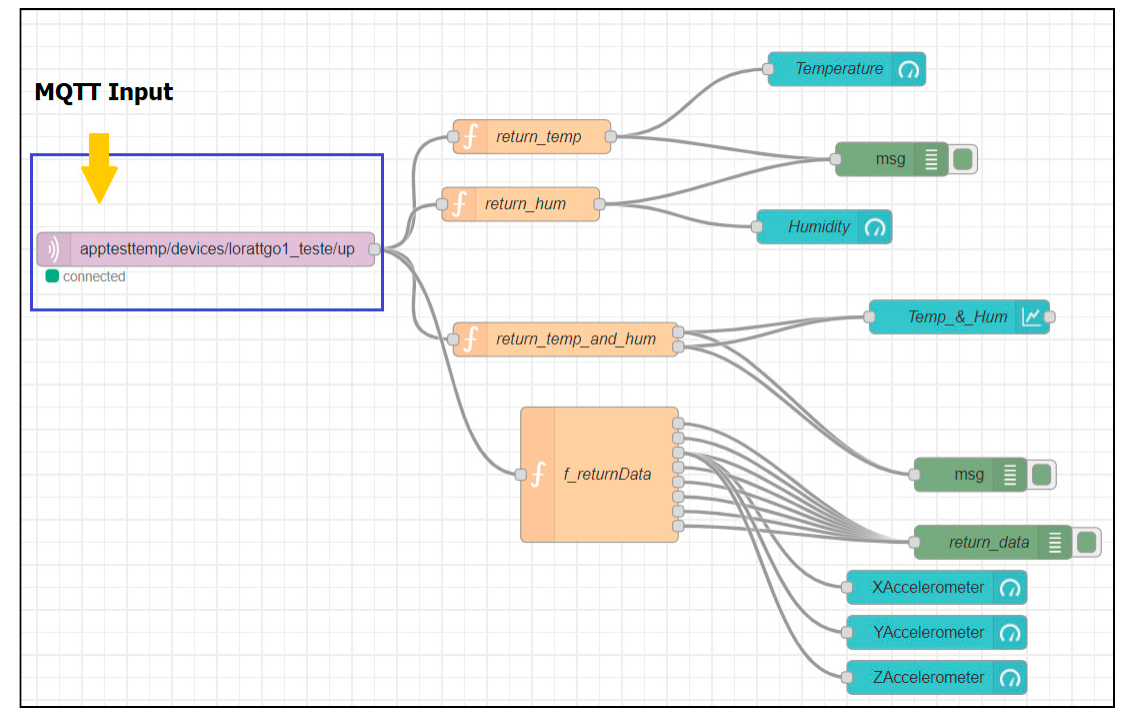
Figure 1. Example of MQTT connection to TTN using Node-RED (source: author’s elaboration).